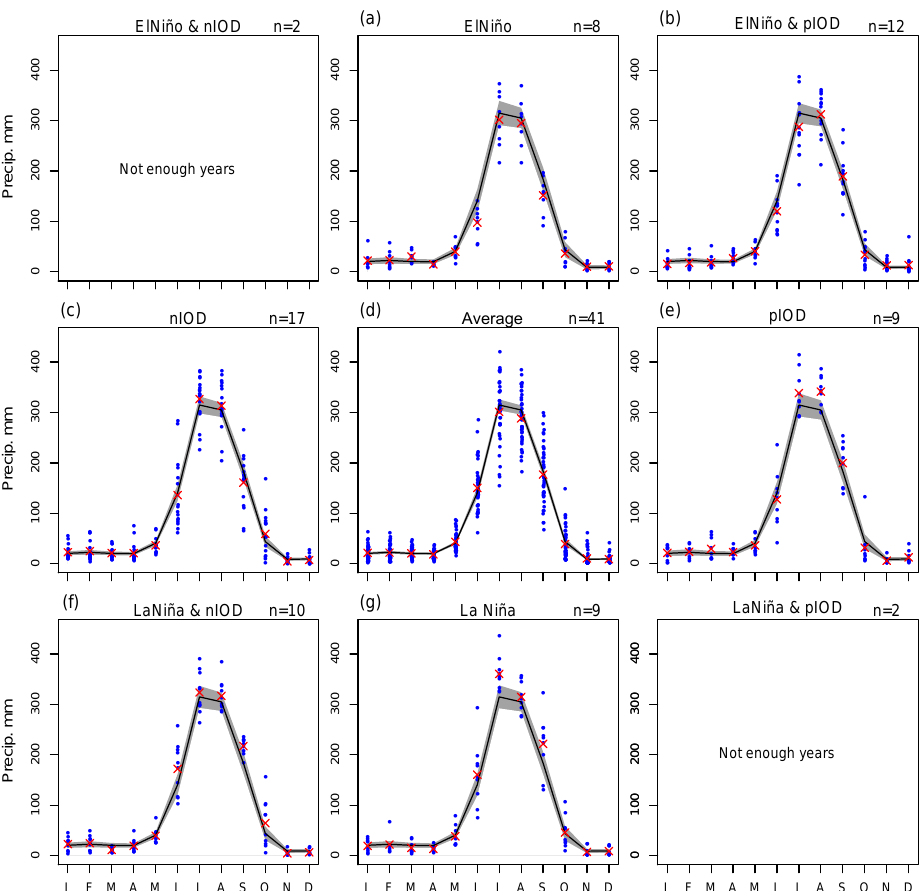
Figure 4. Composite of the Ganges Basin precipitation (mm) by month when El Niño, La Niña, and positive or negative IOD occurred, co-occurred, or did not develop. The number of observed years for each ENSO–IOD combination is indicated with n . The seasonal cycle from January to December is shown for the period 1901–2010. The black line is the mean of all years (1901–2010). Within each combination, observed years ( n) are shown with blue dots, the red X shows the mean of the observed years, and its confidence levels are shown with gray shading as determined by Monte Carlo testing and a two-tailed t test at 80% confidence interval. Where the red X lies outside the gray shaded area, the values are significantly different from the long-term variance of that